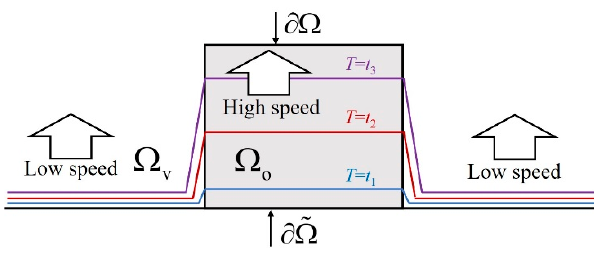
Figure 3. Schematic diagram of obstacle interface regression.